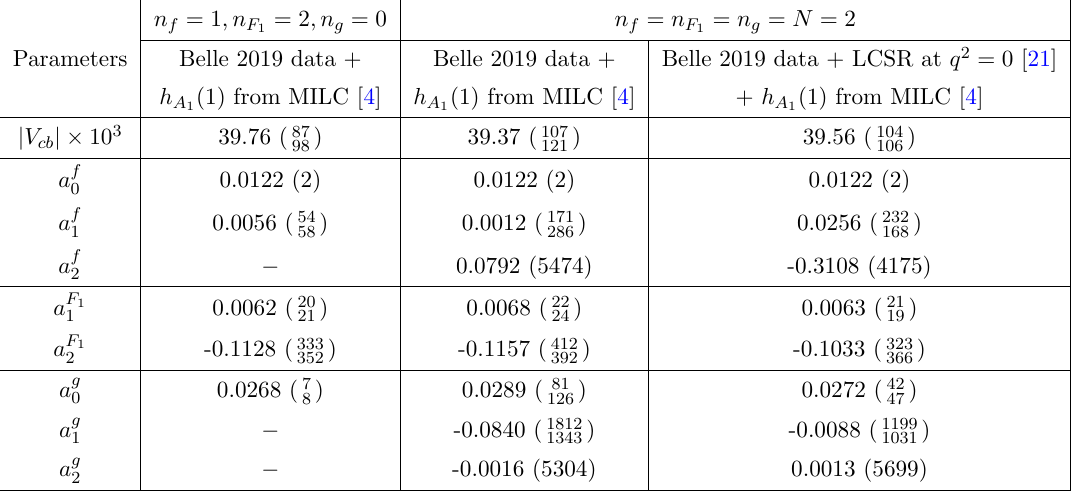
Table 4. The results of the (cid:12)t to new Belle data [17] in B ! D (cid:3) ‘(cid:23) ‘ decay using BGL parametriza- tion of the form-factors for n f = 1 ; n F = 2 ; n g = 0 (second column) and for N = 2 (third 1 column). The last (fourth) column corresponds to the (cid:12)t to new Belle data [17] and LCSR inputs (for q 2 = 0) [21] for N =